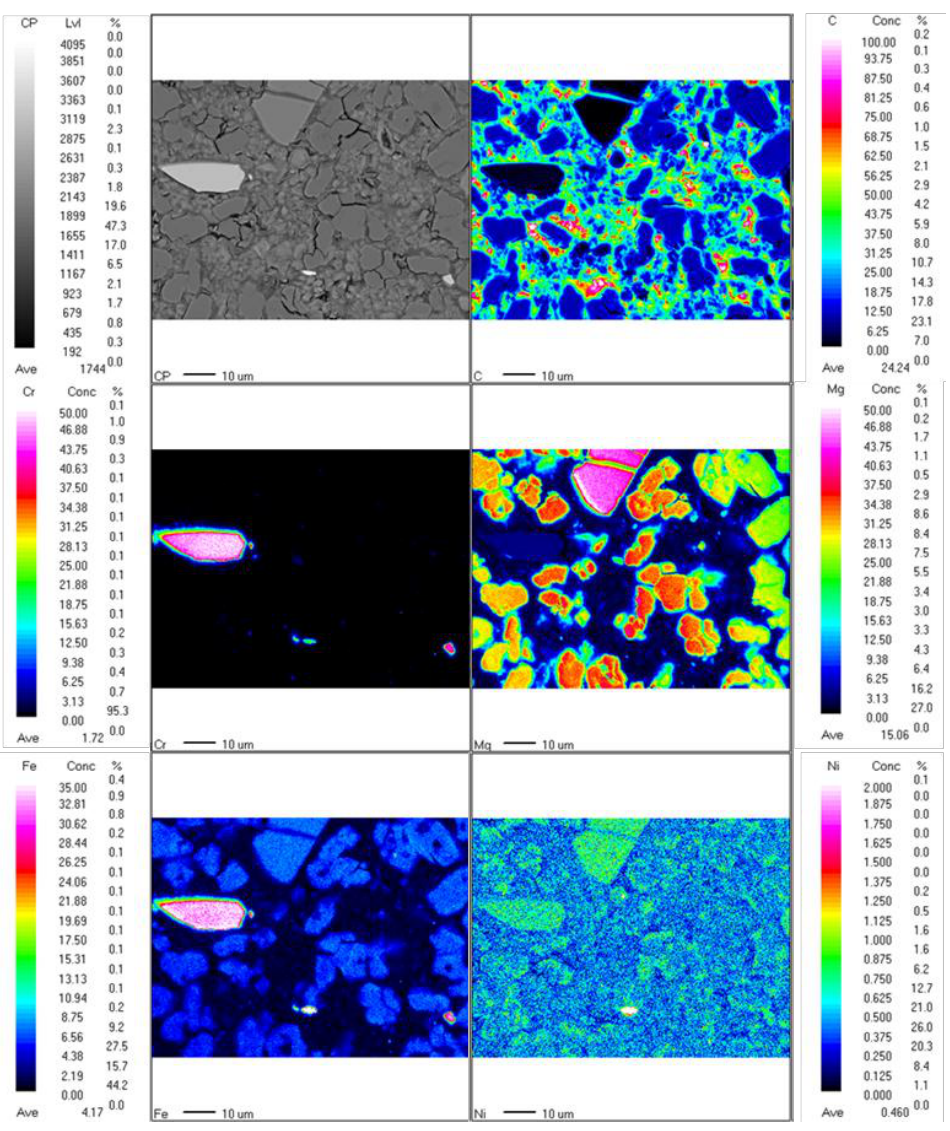
Figure 6. Backscattered scanning electron image and elemental concentration mapping (carbon, chromium, magnesium, iron and nickel) of fully carbonated olivine, captured by EPMA; concentration scale is relative to max/min levels; color gradient in Mg map is due to curvature artifact that occurs at these relatively low